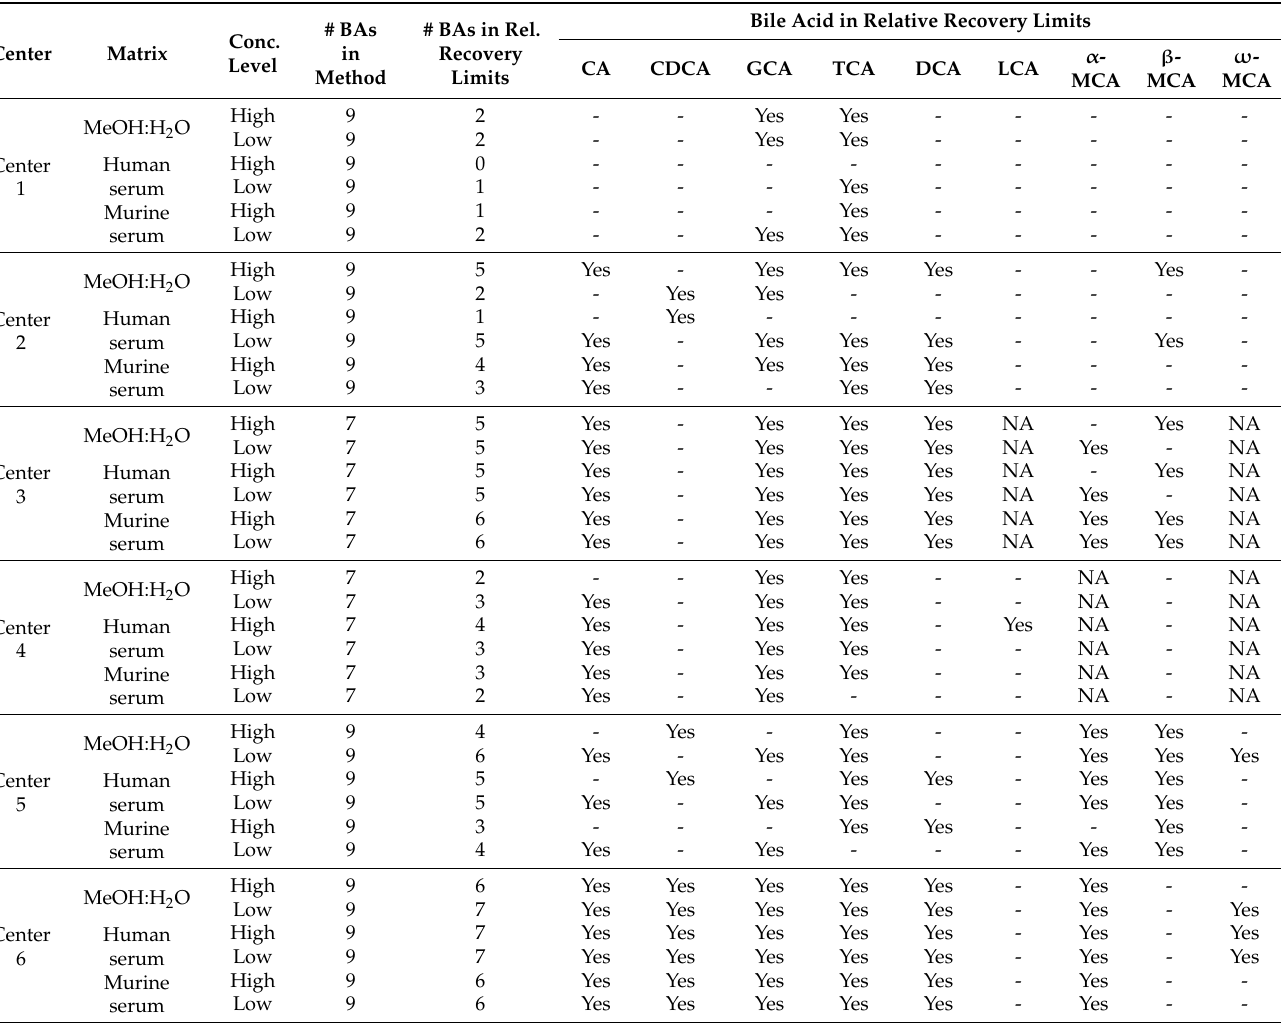
Table 3. Bile acid analyses within accuracy limits based on relative recovery. NA = not applicable, those BAs are not covered by the specific